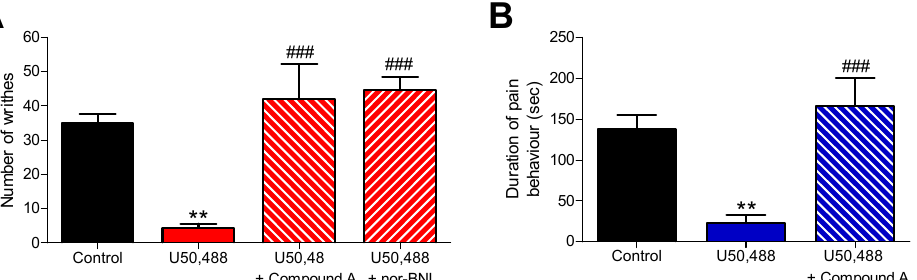
Figure 4. In vivo KOR antagonism of Compound A. Antagonism of U50,488-induced antinociception in mice by Compound A after s.c. administration in ( A ) the acetic acid-induced writing assay and ( B ) the formalin test. ( A ) In the writhing assay, groups of mice received s.c. control (vehicle), U50,488 (2 mg/kg) or were s.c. pre-treated with Compound A (10 mg/kg, − 15 min) or nor-BNI (10 mg/kg, − 24 h) before U50,488, and the number of writhes were counted for 10 min. Values represent means ± SEM ( n = 5–6 mice per group). ( B ) In the formalin test, groups of mice received s.c. control (vehicle), U50,488 (1 mg/kg) or were s.c. pre-treated with Compound A (10 mg/kg, − 15 min) before U50,488, and the duration of pain behavior (time spent licking, biting, lifting and flinching the formalin-injected paw) was counted for 15 min, starting 15 min after formalin injection. Values represent means ± SEM ( n = 6–8 mice per group). ** p < 0.01 vs. control (vehicle) group; ### p < 0.001 vs. U50.488-treated group; one-way ANOVA with Tukey’s post hoc